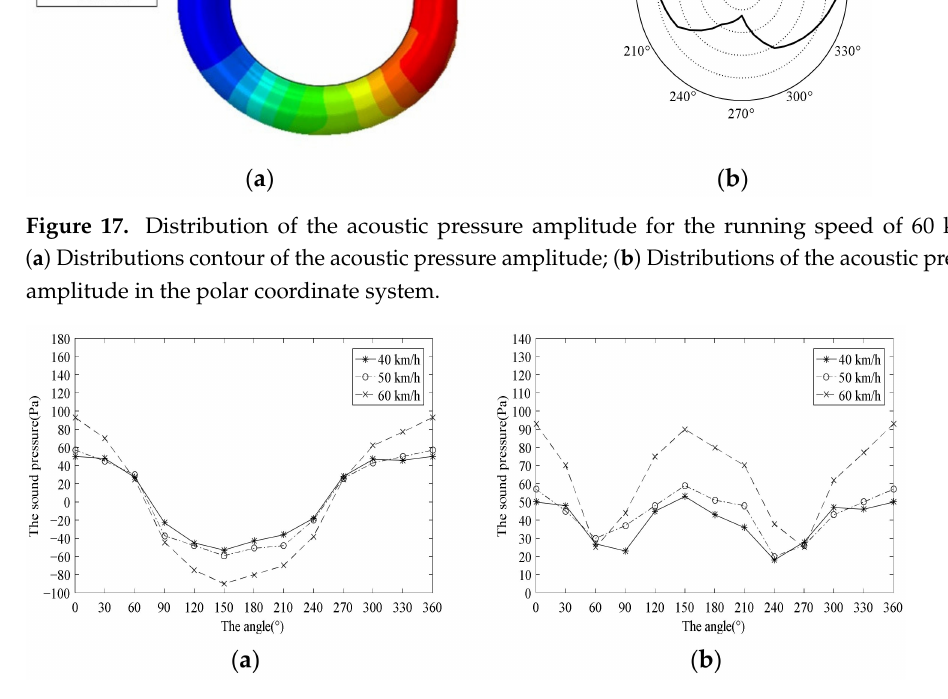
Figure 18. The acoustic pressure amplitude distributions: ( a ) The transient sound pressure distribu- tions; ( b ) The acoustic pressure amplitudes